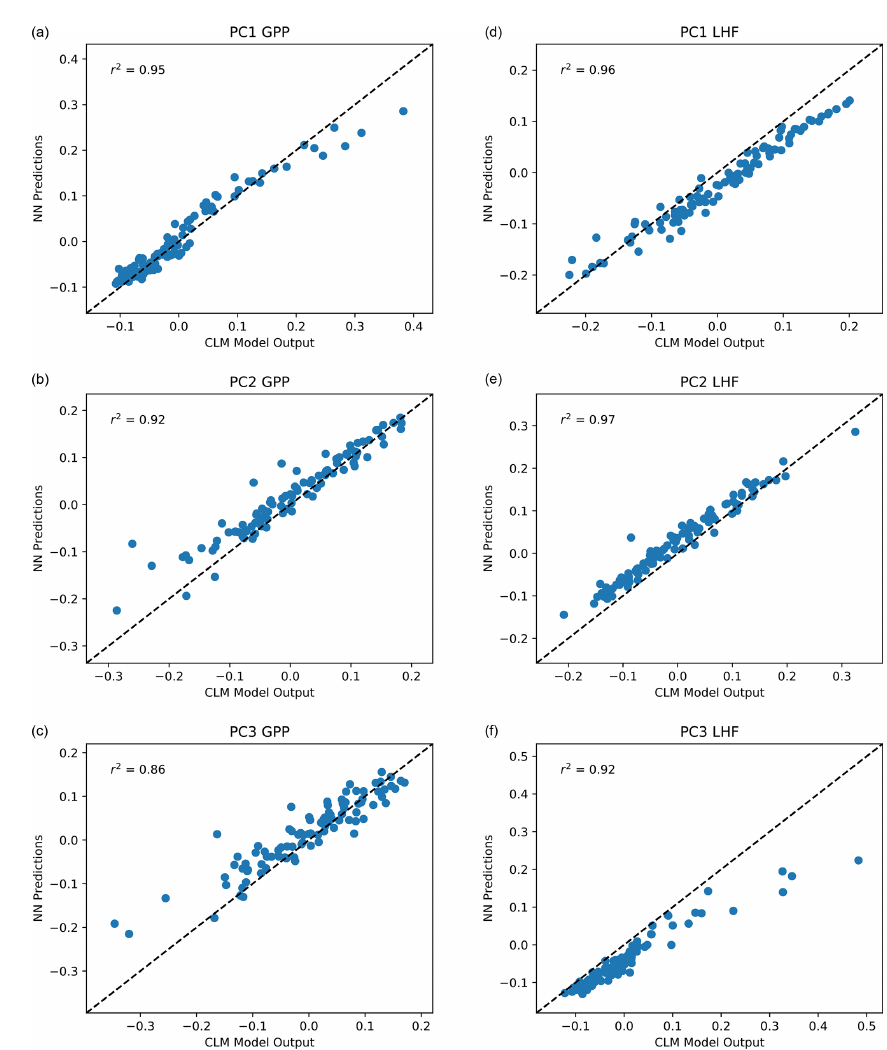
Figure 5. Scatterplot of predicted PC1, PC2, and PC3 for GPP (a, b, c) and LHF (d, e, f) from the neural network emulators versus actual values from CLM output. The one-to-one line is shown in each panel as a dashed black line, and r 2 values from a linear regression fit are included in each panel in the upper left